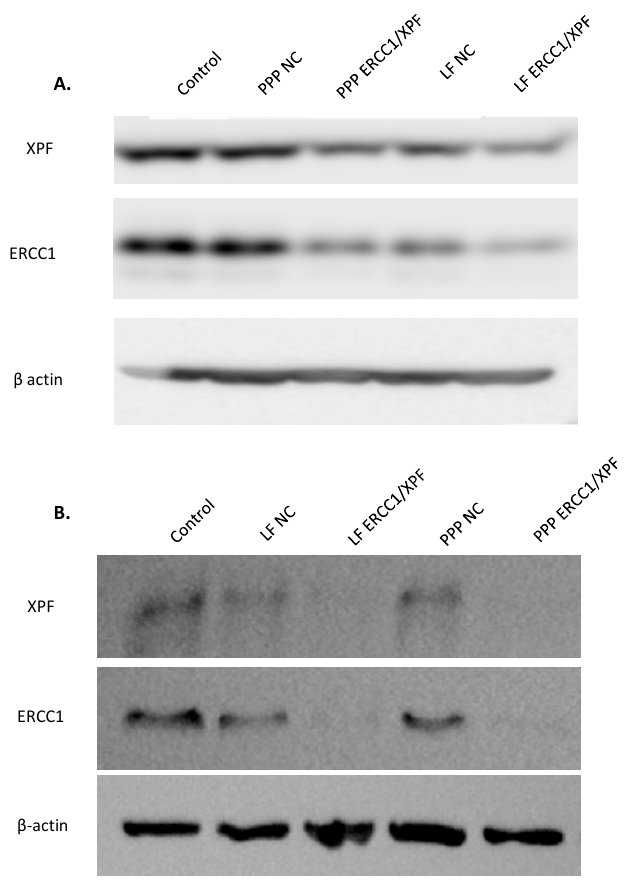
Figure 1. Western Blot analysis of excision repair cross-complementation group 1 (ERCC1) and xeroderma pigmentosum group F (XPF) protein levels within A549 cells following ( A ) single transfection of micelleplexes (PPP) loaded with 50 pmol small interfering RNA (siRNA) after 72h and ( B ) double transfection of micelleplexes (PPP) loaded with 100 pmol siRNA after 72h. Lipofectamine 2000 (LF) lipoplexes were prepared according to manufacturer’s protocol with 50 pmol (A) and 100pmol (B) siRNA (n = 2).